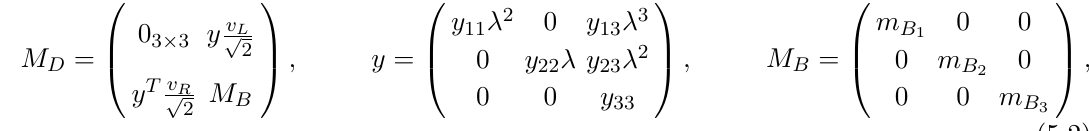
Figure 3 . E(cid:11)ective Majorana neutrino mass parameter neutrino mass m lightest for normal and inverted neutrino mass orderings. The dark regions corre- spond to points satisfying 2 (cid:27) constraints for all mixing parameters. The current sensitivity of the KamLAND-Zen experiment is indicated in